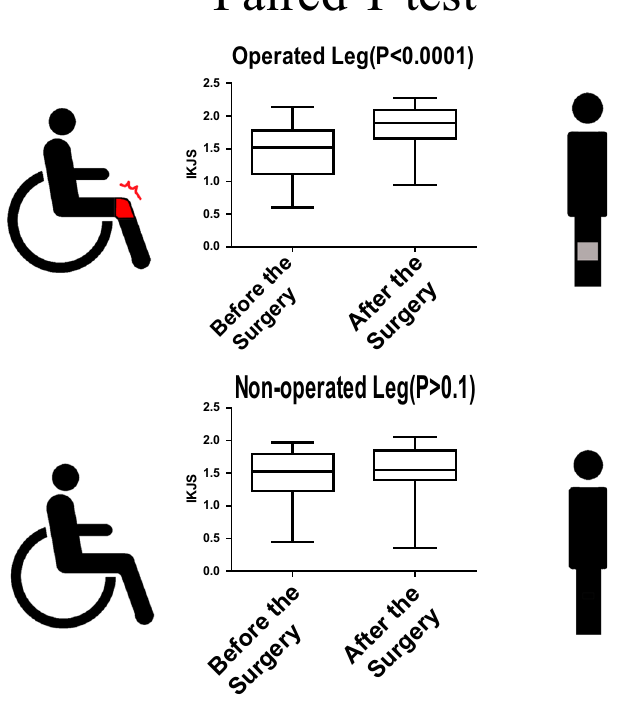
Figure 5. Paired t-test results of IJKS. ( A ) For operated leg pre/post-surgery. ( B ) For non-operated leg pre/ post-surgery. The IKJS of operated leg has a significant improvement while non-operated leg has no significant